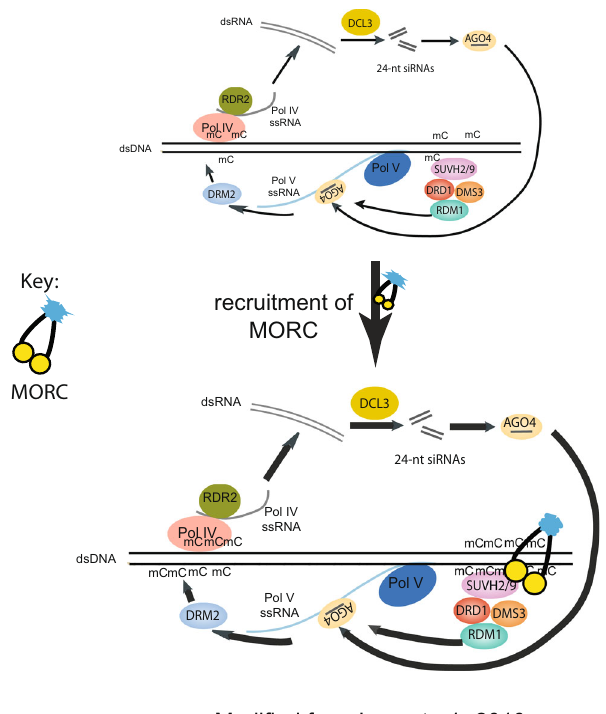
Fig. 7 Working model of MORC proteins. A working model of MORC proteins in plant: MORC proteins are localized to RdDM sites through direct interaction with RdDM components. Upon recruitment, MORCs topologically entrap chromatin through dimerization and clamp around DNA to continuously reinforce the recruitment of RdDM complexes to their site of action and thereby, facilitate the ef fi ciency and activity of the RdDM subset of sites. A previous analysis of the morc hextuple mutant